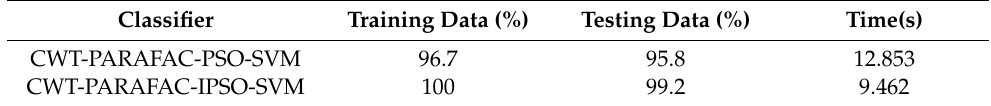
Table 7. Correction rate of two classifiers with multi-channel data